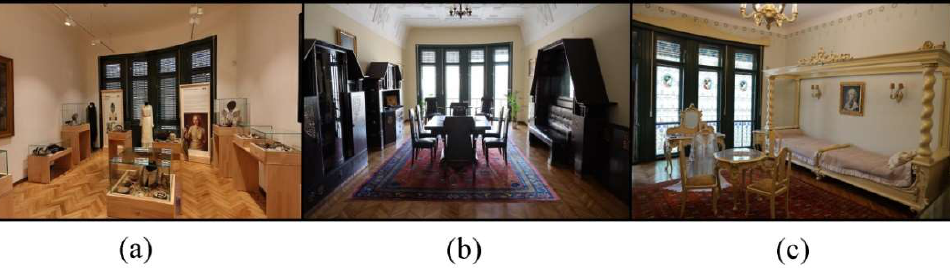
Figure 2. The three rooms within the Darvas-La Roche House that were monitored in order to determine the characteristics of the internal microclimate (( a )—Exhibition hall on the ground floor; ( b )—Great hall; ( c )—Bedroom).